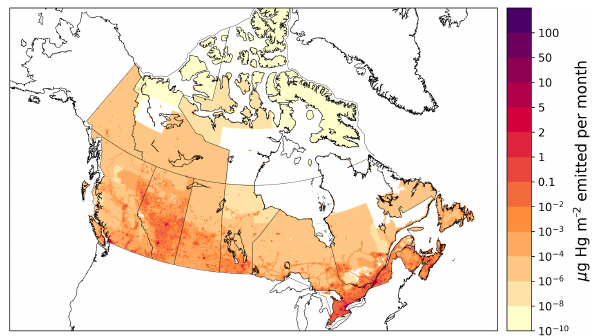
Figure 8. Total mercury emissions (TAM) from anthropogenic ac- tivity in Canada, given in µgm − 2 month, averaged over the burning season